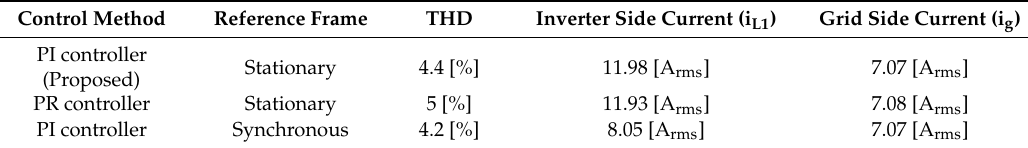
Table 3. Summary of steady-state simulation results in Figure 7.